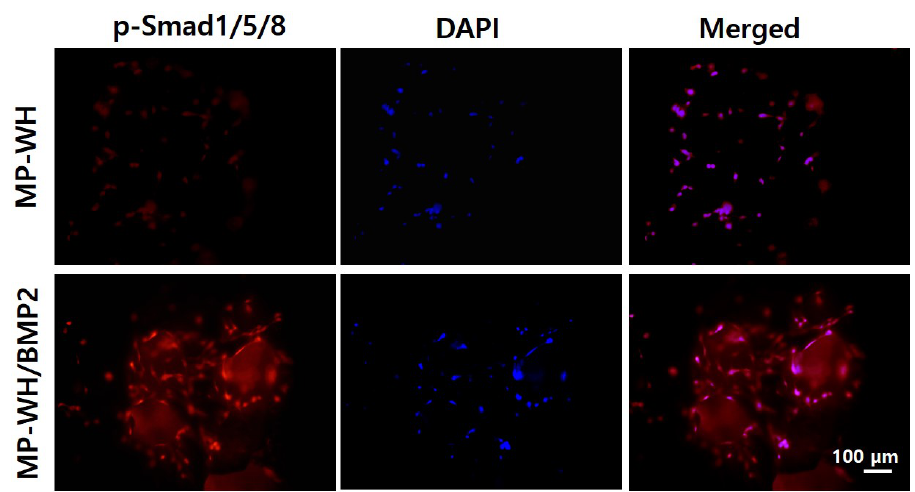
Figure 9. Activation of MP-WH/BMP2-induced pSmad 1/5/8 signaling: hMSCs cultured on MP-WH and MP-WH/BMP2 granules, and Smad 1/5/8 phosphorylation detected by immunofluorescence staining via DAPI (blue) and anti-pSmad 1/5/8 (red).